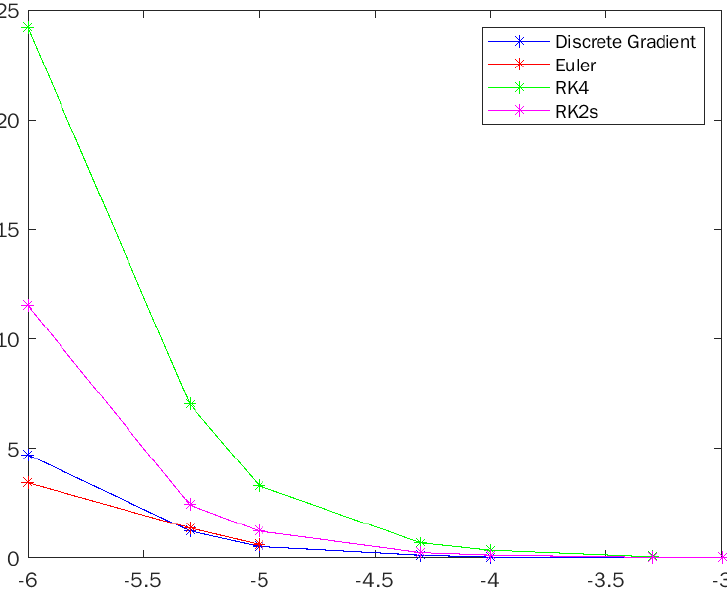
Figure 9. Computational cost for different values of h